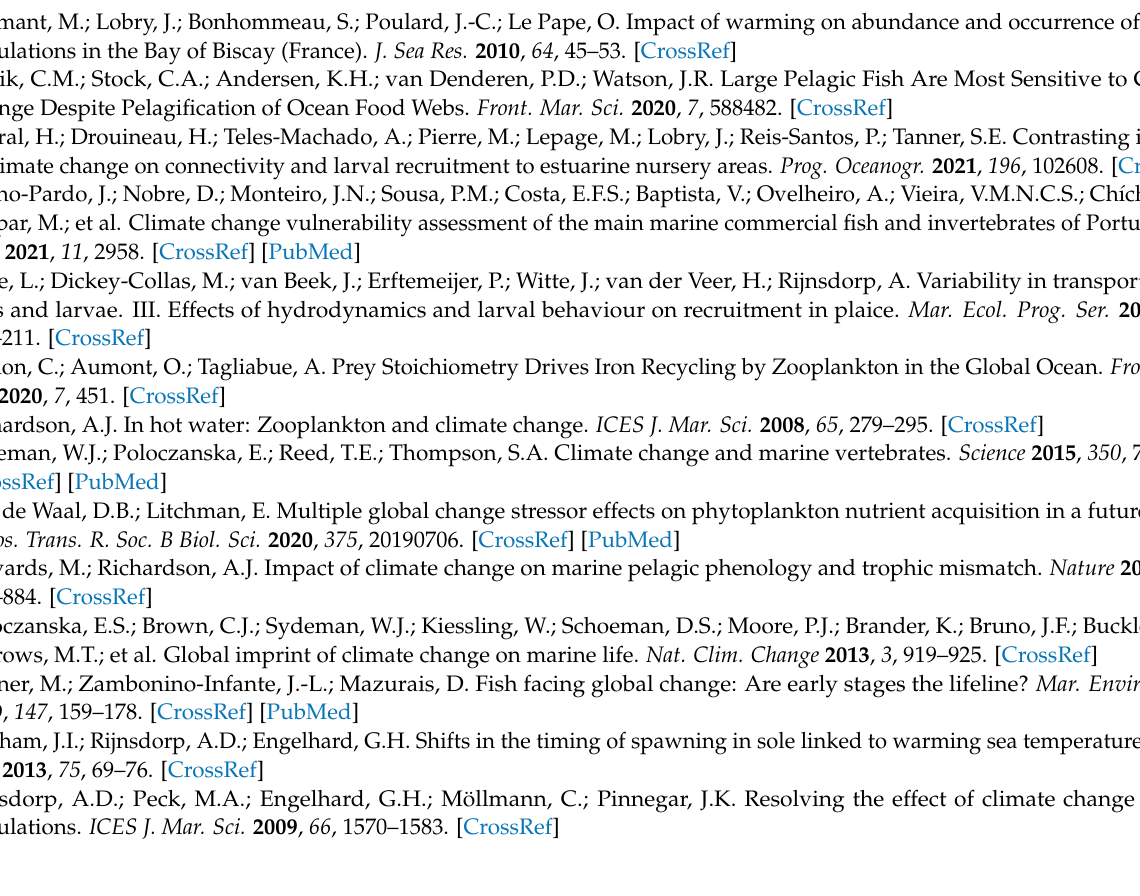
Figure A6. Growth rates in Solea spp. larvae (from hatching until complete metamorphosis) and juveniles (from metamorphosis until maturation). Green rectangles mark the individuals that spawned the earliest, with date of spawning indicated as the day of the year (number) under the bars. Colors of the bars correspond to color-coding of scenarios (S) in Figures 5 and 6 of the manuscript: black—S1 baseline, blue—S2 and S3 food availability modifications, yellow—S4 and S5 temperature increase, red—S6 and S7 food decrease combined with temperature increase. For scenario descriptions please see Table 1 of the manuscript.